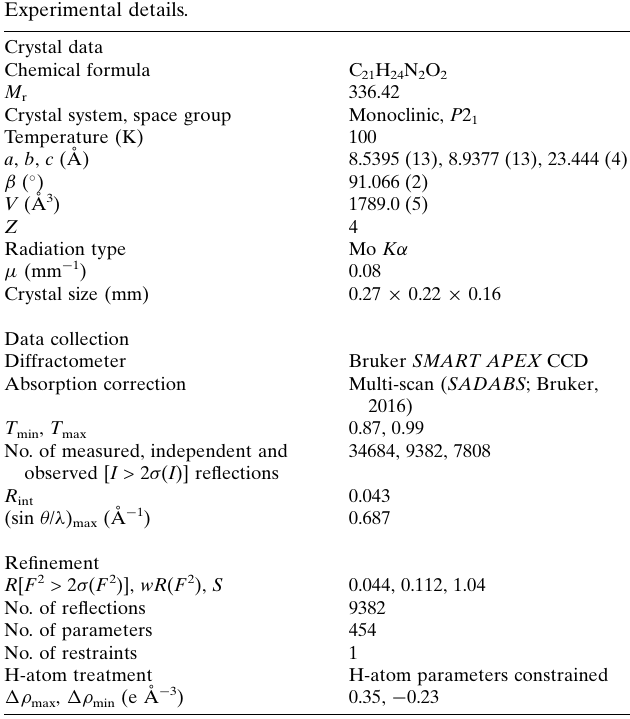
Table 2 Experimental details.